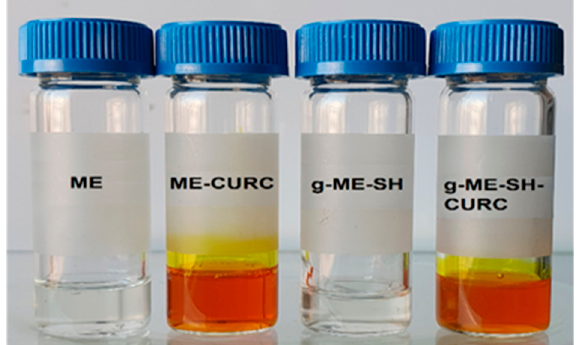
Figure 1. Visual aspect of microemulsion and gel microemulsion with sodium hyaluronate (see Table 1) with and without encapsulated CURC.